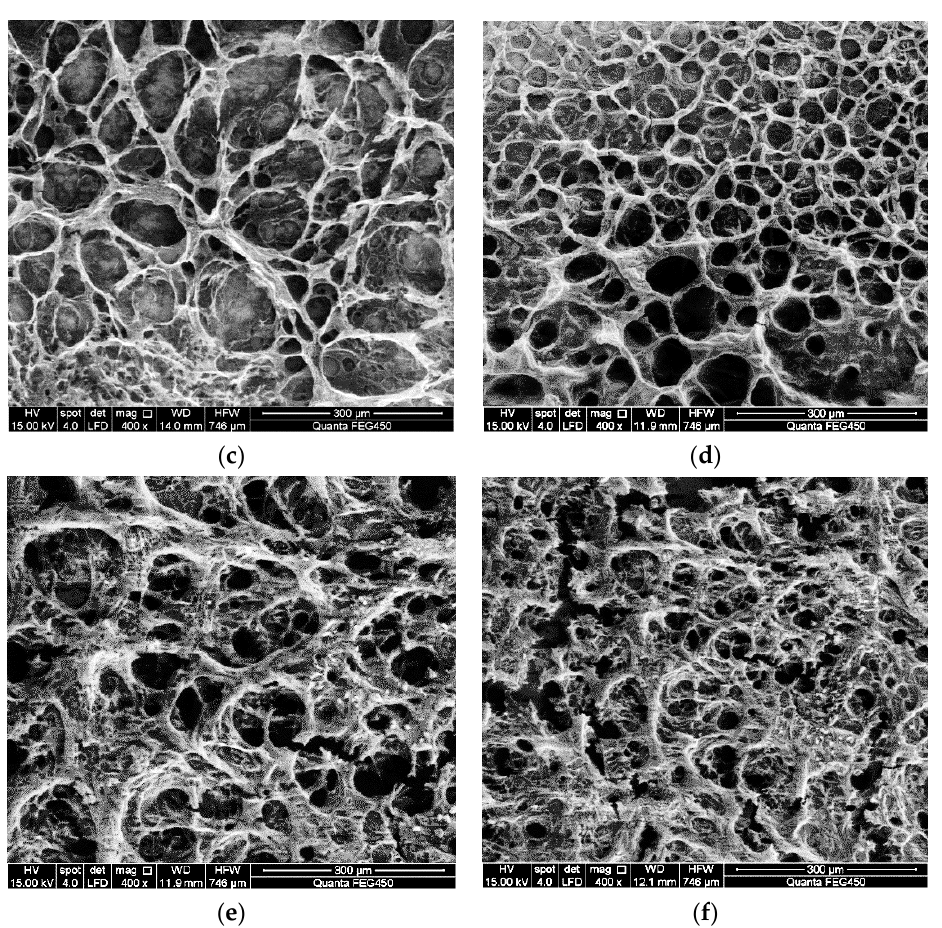
Figure 4. Molecular morphology of alkali / surfactant / polymer (ASP) solution: ( a ) 16 million (MD), 1000 mg / L; ( b ) 16 million (MD), 2000 mg / L; ( c ) 19 million (MD), 1000 mg / L; ( d ) 19 million (MD), 2000 mg / L; ( e ) 25 million (MD), 1000 mg / L; ( f ) 25 million (MD), 2000 mg / L.